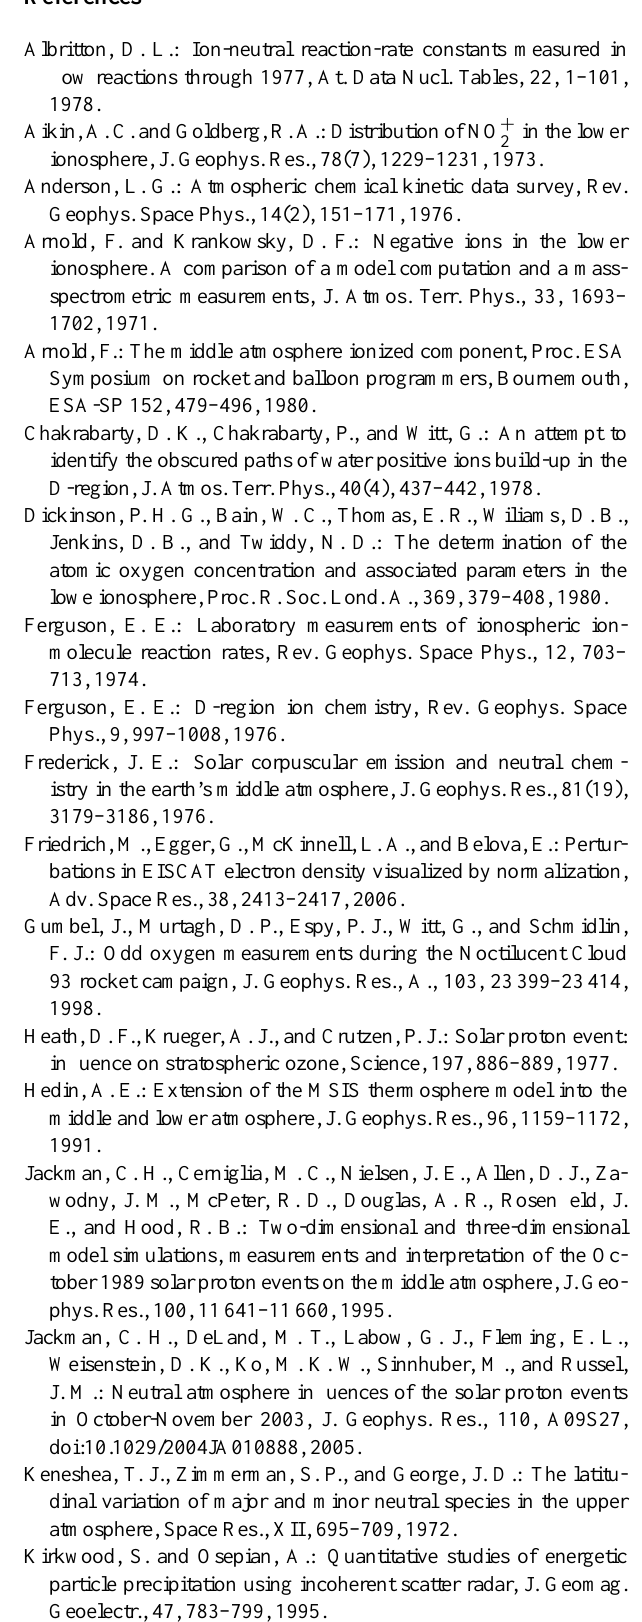
Table A3. Rate constants for negative ion